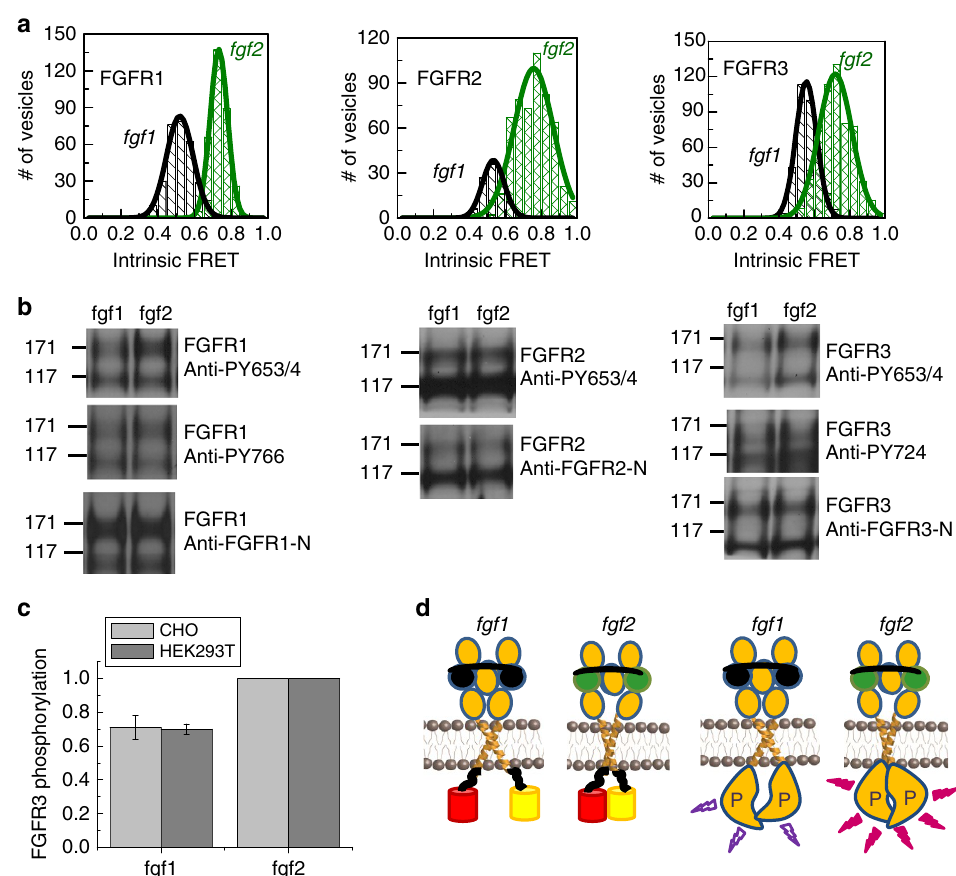
Figure 3 | Conformational changes and activation of the FGF receptors. ( a ) Histograms of single-vesicle intrinsic FRET values, measured for the three FGF EC þ TM receptor constructs in the presence of saturating fgf1 (black) or fgf2 (olive) concentrations. Intrinsic FRET is a measure of the separation between the fluorescent proteins in the dimer. Two different intrinsic FRET values were measured for fgf1 and fgf2. Therefore, the binding of these two ligands to the extracellular domains leads to different separation of the fluorescent proteins on the cytoplasmic side of the membrane (Table 2). ( b ) Western blots, reporting on the phosphorylation of the full-length receptors in the presence of saturating concentrations of fgf1 and fgf2 (5 m gml (cid:2) 1 ). Expression of the receptors was probed with antibodies to the extracellular domains of the three receptors. Phosphorylation was assayed using antibodies against phosphorylated tyrosines in the activation loop of the three kinases (anti-phospho-Y653/4) or other phosphorylated tyrosine residues. Two bands are observed for all receptors. Only the top bands, corresponding to the fully glycosylated mature receptors that reside primarily in the plasma membrane, were considered in our analysis. There is a difference between the phosphorylation in response to fgf1 and fgf2 for FGFR1 and FGFR3, but not for FGFR2 (see text). ( c ) Relative FGFR3 phosphorylation in response to fgf1 and fgf2 is quantified and compared using a t -test. Five independent experiments were performed in two cell lines, CHO and HEK 293T. Phosphorylation was calculated by dividing the intensities of the anti-phospho-Y bands to the intensities of the anti-receptor bands, and scaled to the fgf2 case. The difference in FGFR3 phosphorylation in response to fgf1 and fgf2 is highly statistically significant ( P o 0.01). ( d ) Graphic representation of the findings that the fgf1- and fgf2-bound states are structurally and functionally distinct. Left: graphic (not to scale) representation of the finding that the average distance between the fluorescent proteins is larger when fgf1 is bound, as compared with the fgf2-bound case. Right: graphic representation of the finding that phosphorylation is higher when fgf2 is bound. The representation of the kinase domains is a cartoon, not based on structural